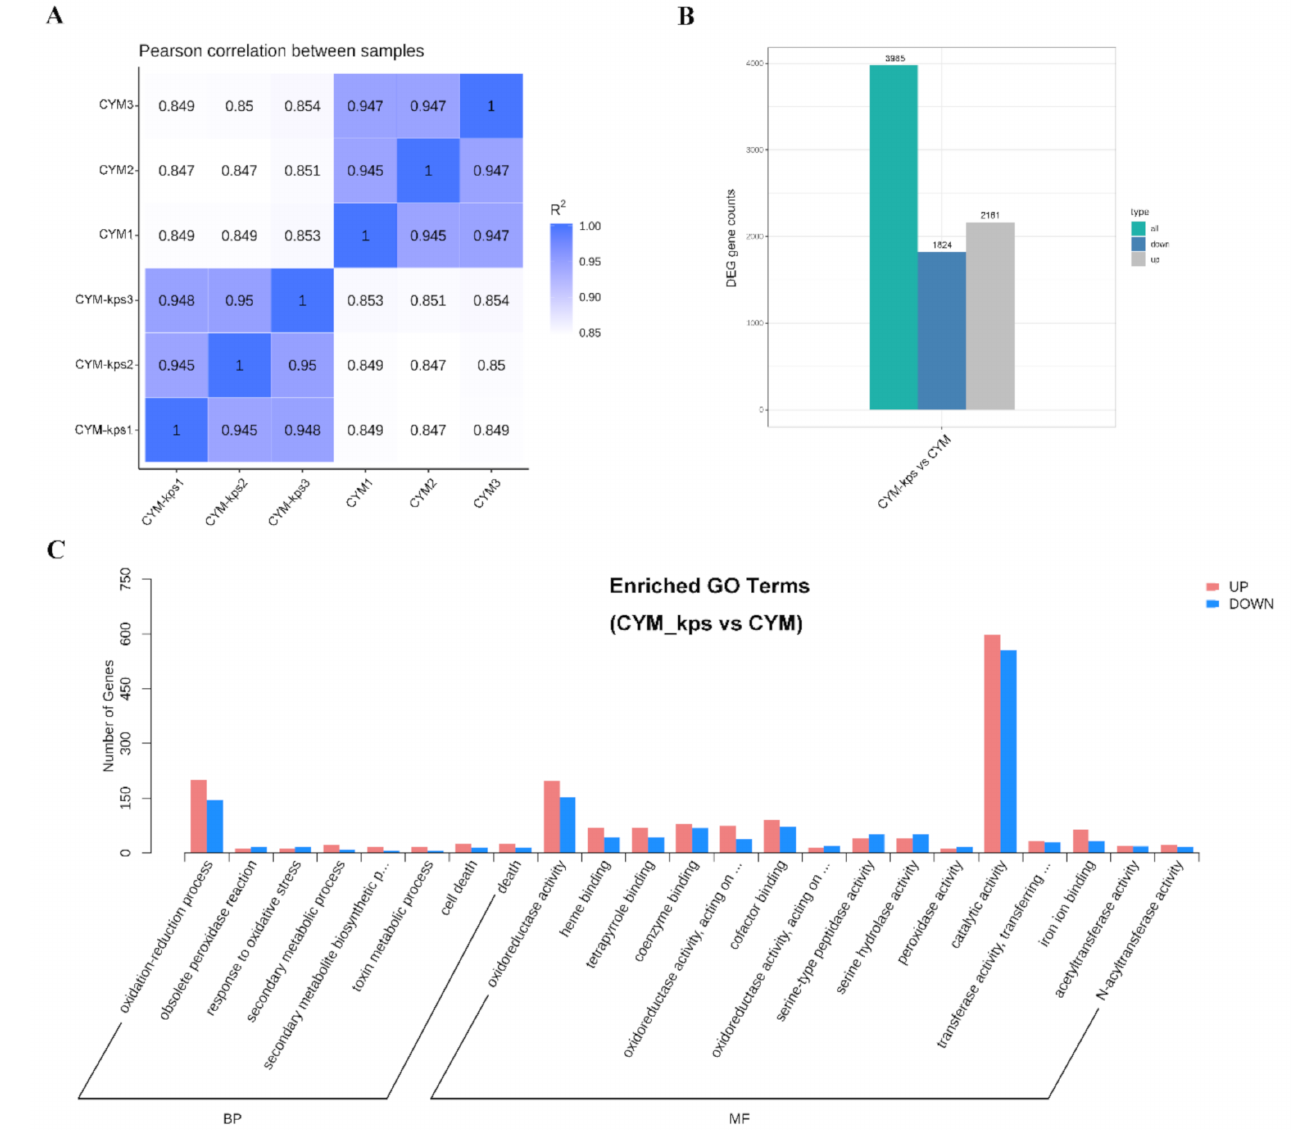
Figure 2. Qualitative transcriptomic analysis of A. cornea. ( A ) Pearson correlation between samples. ( B ) the differential expressed genes counts. ( C ) GO classification analysis of different samples.